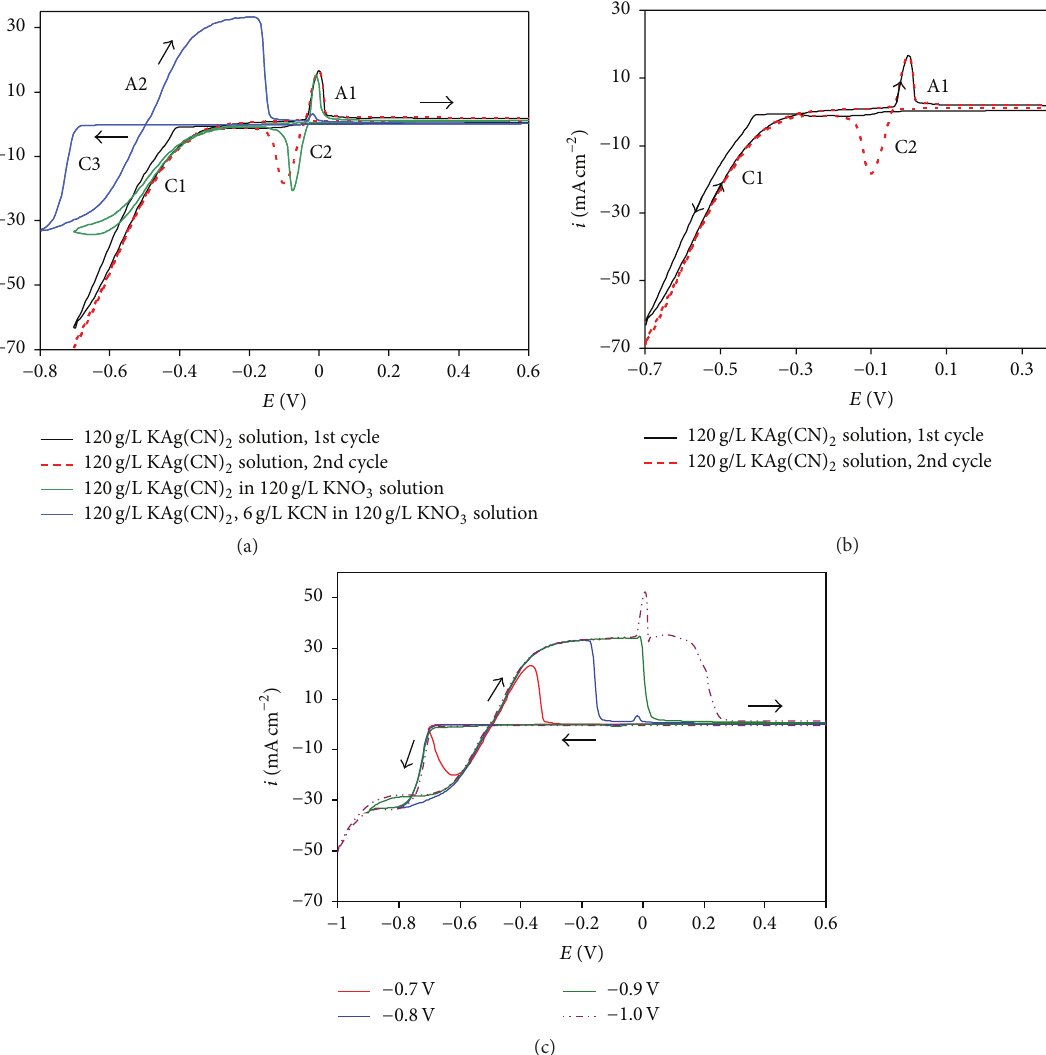
Figure 1: Cyclic voltammograms of (a) silver electrodeposition and silver dissolution in the absence and presence of KNO 3 and KCN; (b) 120 g/L KAg(CN) 2 only; (c) the influence of cathodic vertex potential in 120 g/L KAg(CN) 2 , 6 g/L KCN, and 120g/L KNO 3 solutions. Arrows show the potential sweep direction. Initial potential = +0.6 V. Sweep rate: 50 mVs −1 . C1, C2, and C3 denote the cathodic peaks while A1 and A2 correspond to the anodic